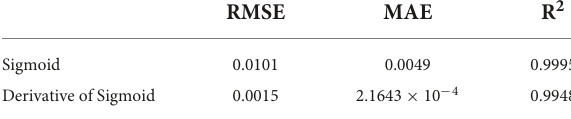
TABLE 3 Error evaluation